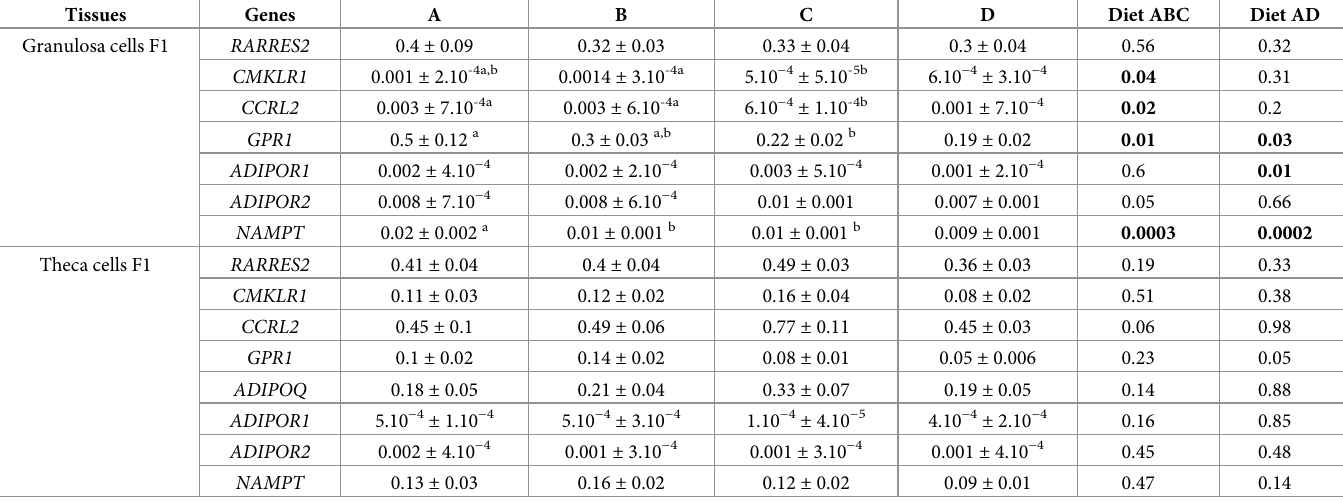
Table 5. mRNA expression of adipokines (RARRES2, ADIPOQ, NAMPT) and their receptors (CMKLR1, CCRL2, GPR1, ADIPOR1, ADIPOR2) in granulosa and theca cells from preovulatory follicle 1 (F1).